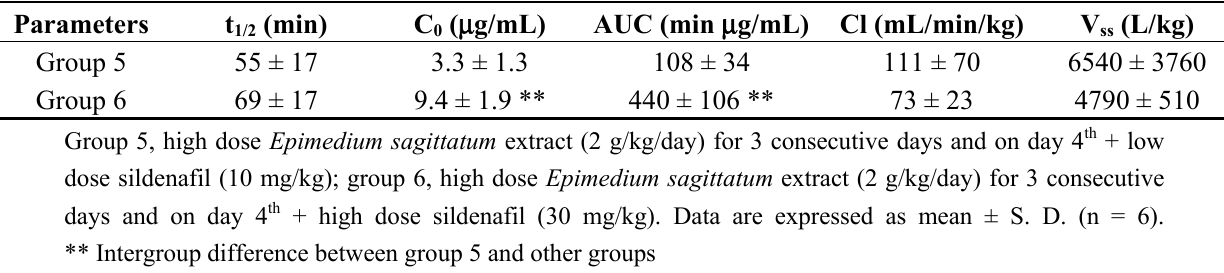
Table 4. Pharmacokinetic parameters of sildenafil in group 5 and 6.